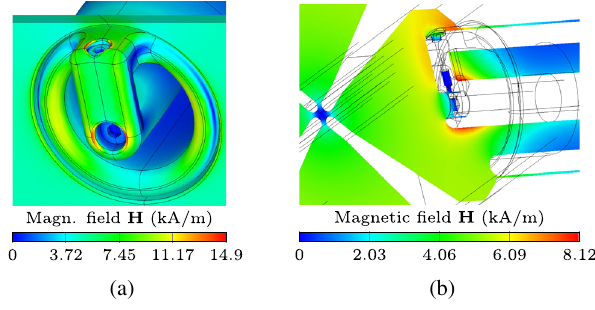
FIG. 11. Magnetic field at input power coupler at ϕ ¼ π = 2 when the field has its maximum value. Hot spots are located on the edges of the bolt holes (a), while generally high currents are located on the edges of the loop and the border of the outer conductor (b).